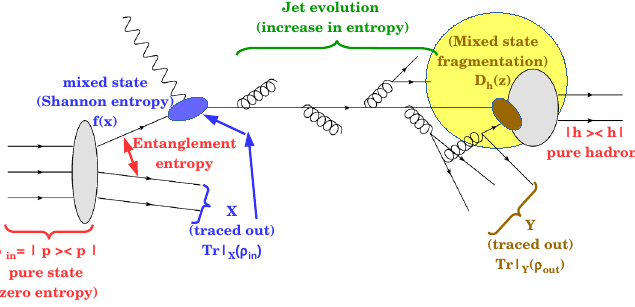
Figure 1. Illustration of the parts of a high-energy process for which entropy has been worked